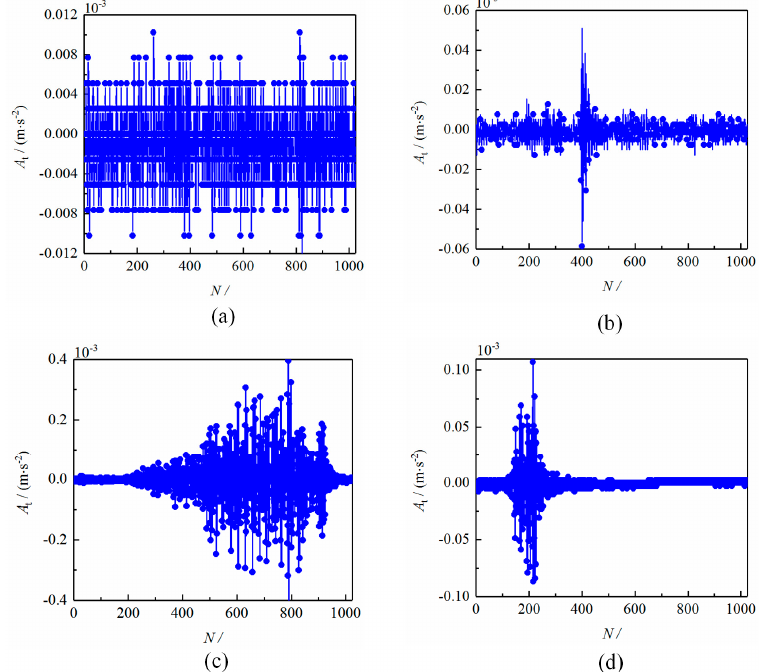
Figure 10. Experimental time-domain characteristics of the vibration signal. ( a ) Single water phase, ( b ) Oil – water two-phase, ( c ) Gas – oil – water mixing phase, ( d ) Single gas phase. ( b ) Oil–water two-phase, ( c ) Gas–oil–water mixing phase, ( d ) Single gas